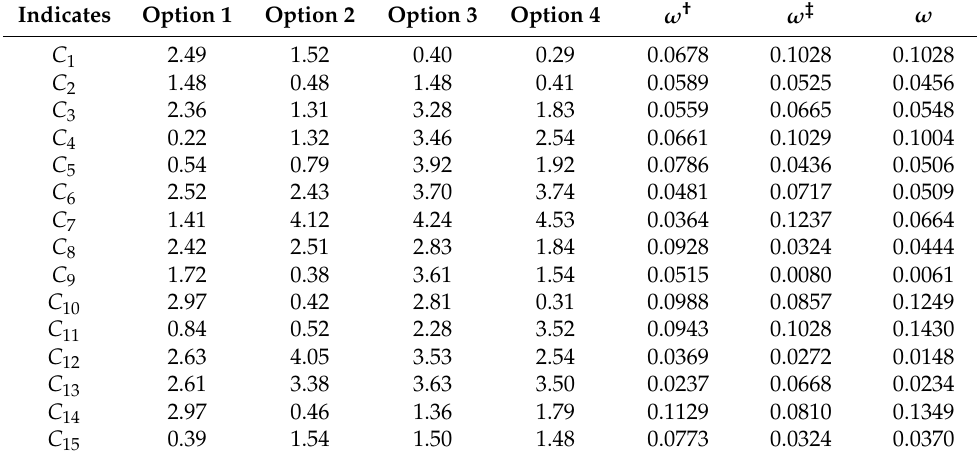
Table 5. Intermediate results of the MULTIMOORA-based risk evaluation approach.